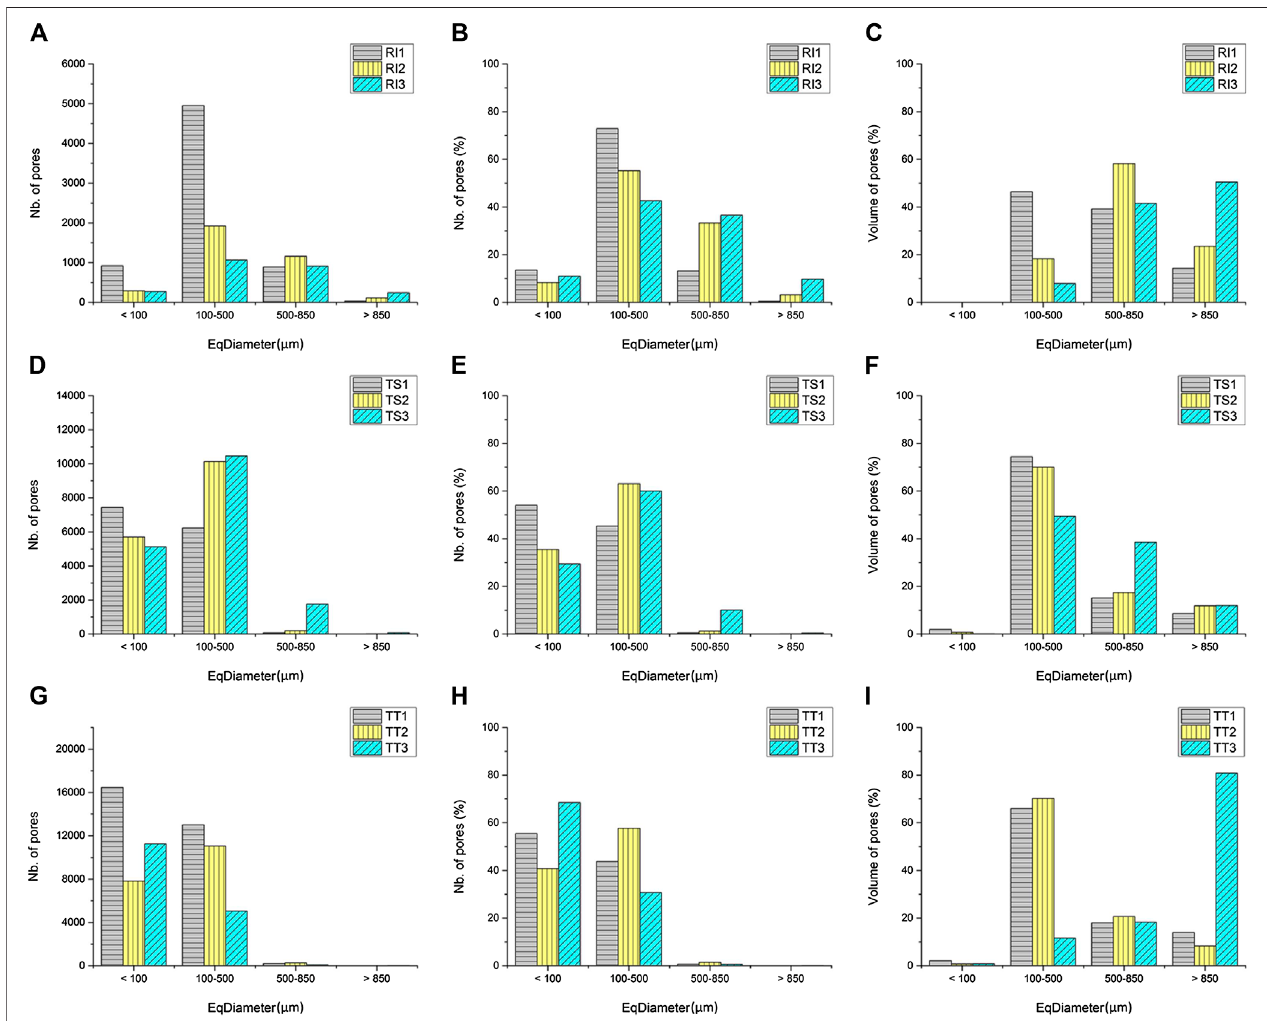
FIGURE 12 | Graphic representation of the pore size distribution of the analyzed alkali-activated foams cured at 1,000 ° C (RI, TS, and TT fl y ash used, 1, 2, and 3 representtheamountoffoamingandstabilizingagentsadded; (A) – (C) RI fl yash, (D) – (F) TS fl yash, (G) – (I) TT fl yash),determinedbymeansofX-raymicro-tomography. The results show the number, percentage, and volume of pores with regard to pore size diameter (EqDiameter).